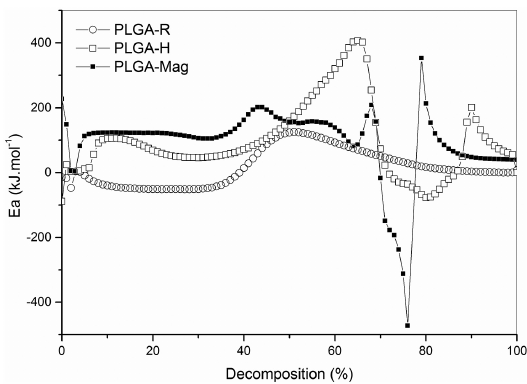
Figure 3. DTG curves for PLGA-R, PLGA-H and PLGA-Mag. N flow rate 50.00 mL.min –1 , heating rate of 2.5 °C.min –1 .